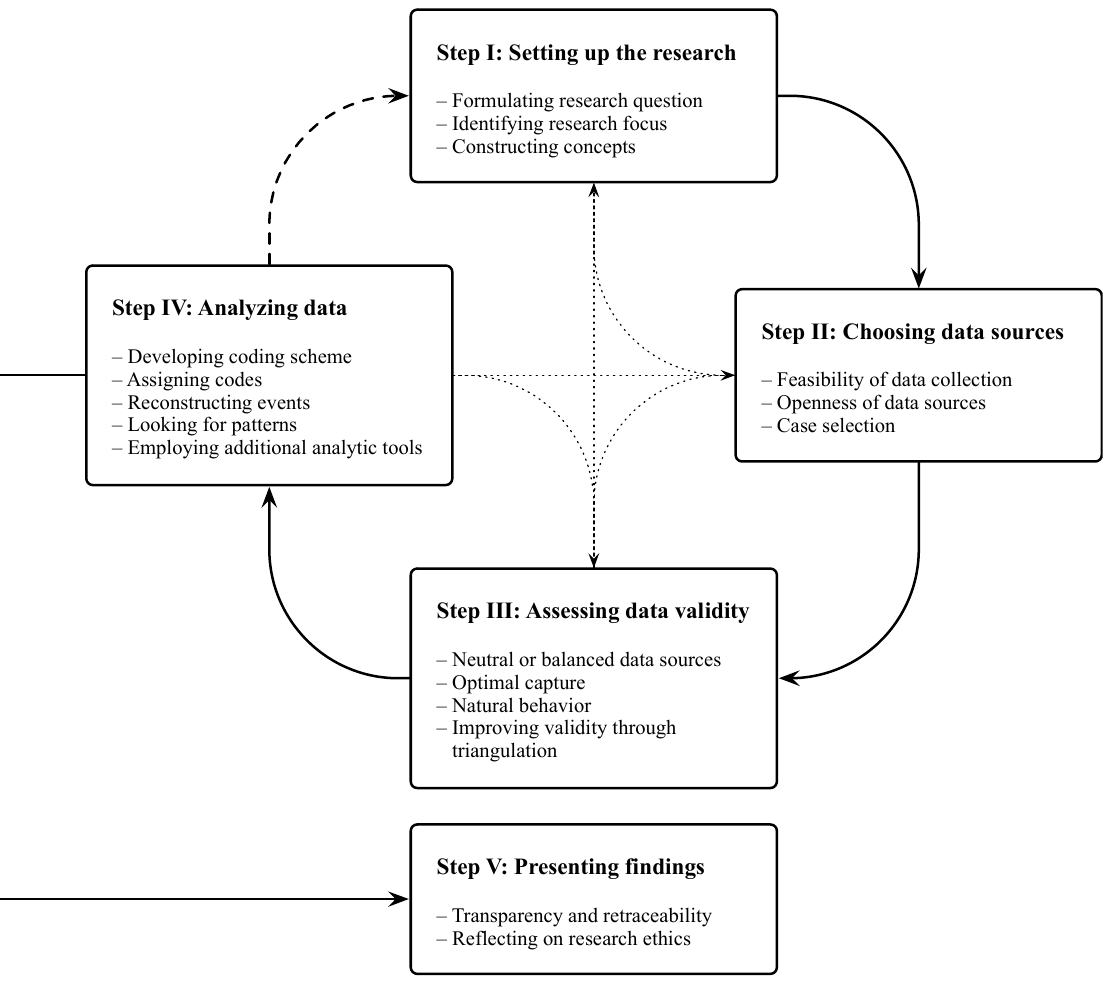
Figure 1. The Video Data Analysis (VDA) research process.